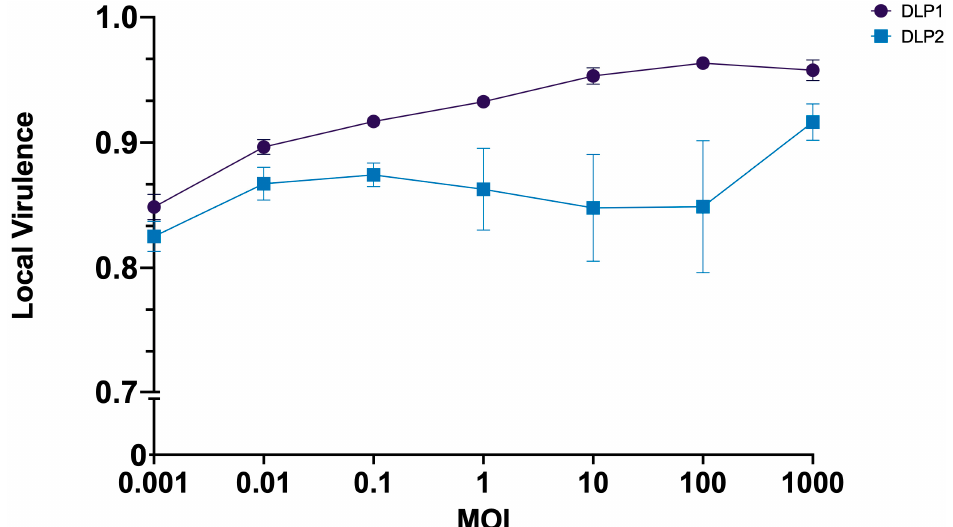
Figure 5. Virulence index of phages DLP1 ( ● ) and DLP2 ( ■ ) against A. baumannii AB5075 cm . The OD 600 of kill curves was measured across known MOIs (Figure 4) and virulence curves were gener- ated as described in the methods section. A virulence index of 1 signifies theoretical maximum vir- ulence. The data represent mean and standard deviation of technical and biological triplicate exper- iments.